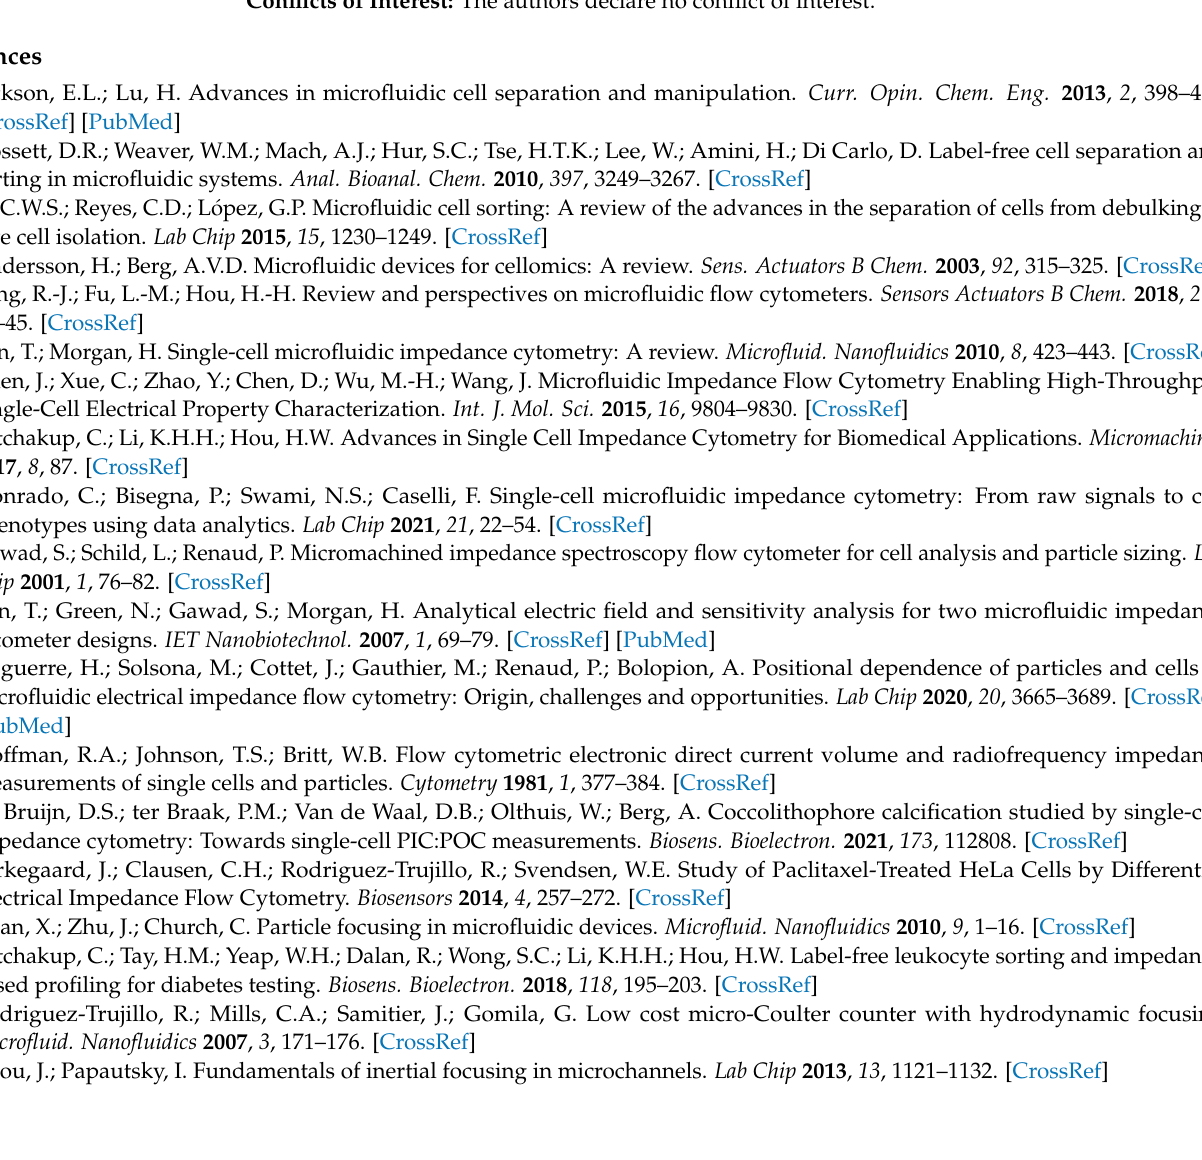
frequency analysis. Figure S3: Optical investigation yeast. Figure S4: Fitting parameters yeast experiment. Figure S5: Corrected diameters yeast